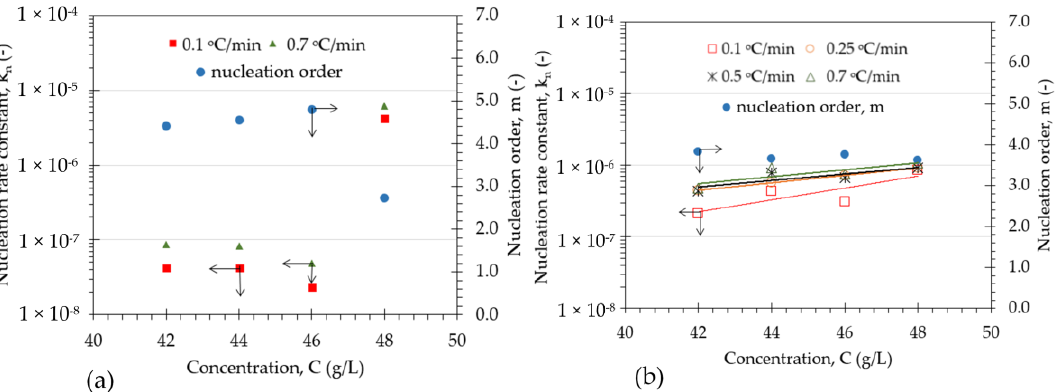
Figure 4. Nucleation order and nucleation rate constant of L-isoleucine in solution with various heating/cooling rates for ( a ) 0 V and ( b ) 5 V. The plotted values for 0 V were calculated from data obtained from Anuar and co-workers [7,39]. The blue dots in both figures represent the nucleation order, m (secondary